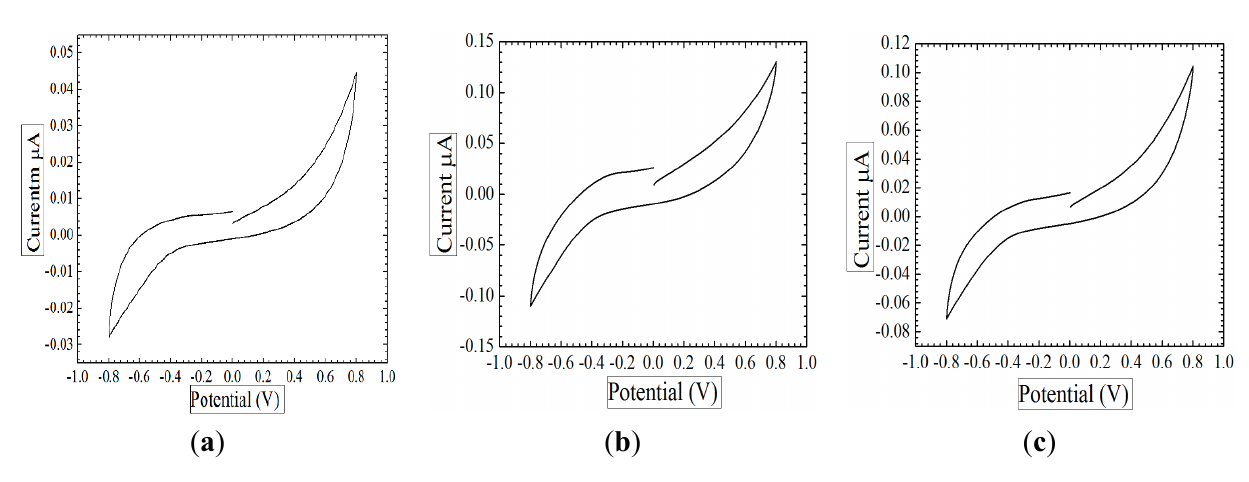
Figure 6. The oxidation reduction of glucose at the peak of 0.8 V is illustrated in the cyclic voltammetry curve of the ZnO nanorods electrochemical sensor where ( a ) is in the absence of glucose; ( b ) is at 1 mM glucose concentration; and ( c ) is at 2 mM glucose concentration.